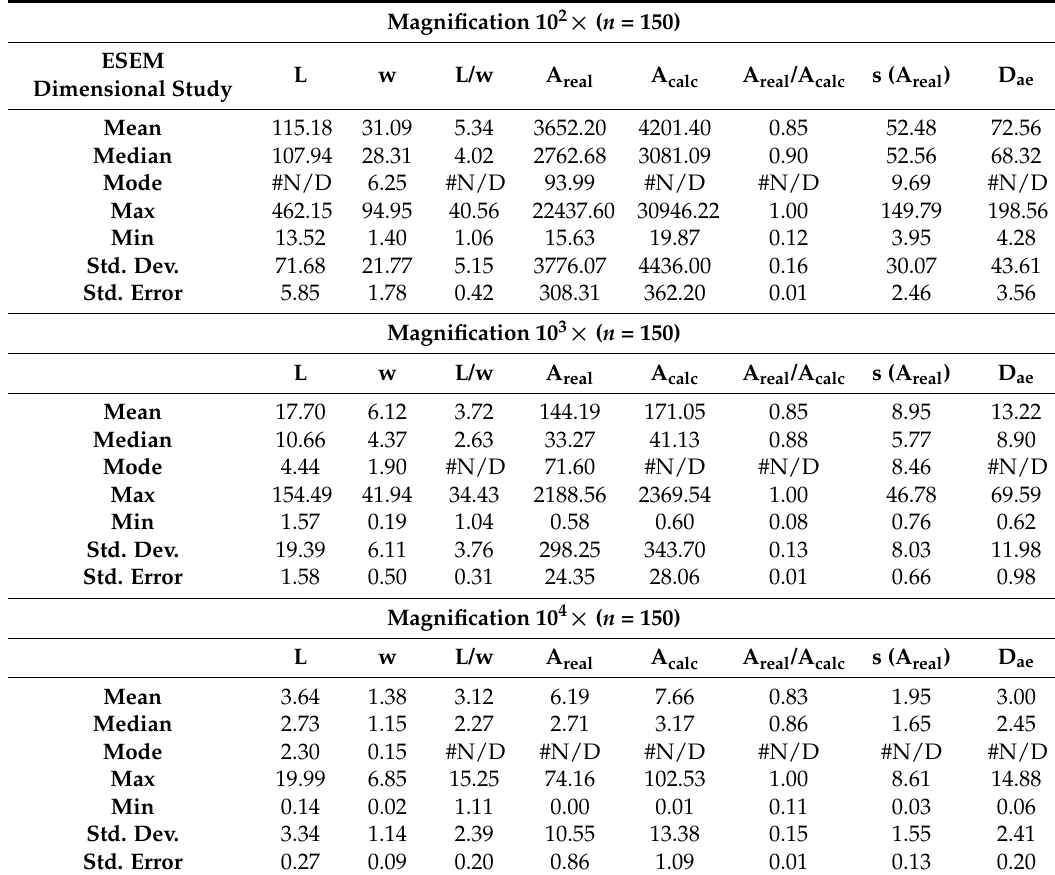
Table 6. Measurements of length ( L ), width ( w ), area ( A real ), calculated area ( A calc ), area ratio, “ s ” dimension, and aerodynamic diameters ( D ae ) at different magnifications for the sample ( after the dissolution experiment).